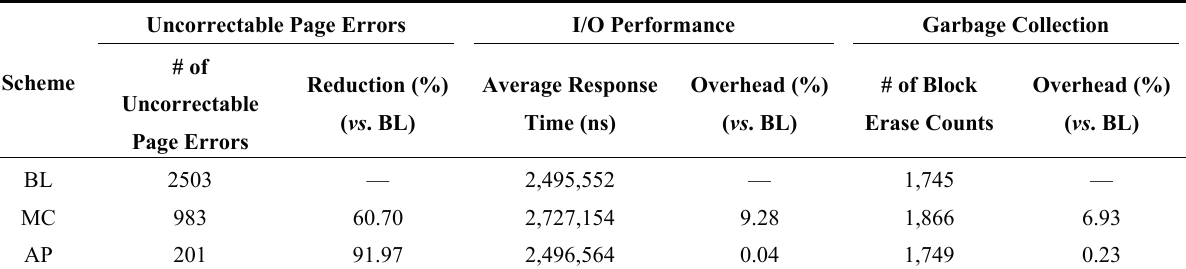
Table 4. The experimental results of Baseline, Meta-Cure, and Asymmetric Programming with Zynq on-board sensor system (BL: Base Line; MC: Meta-Cure; AP: Asymmetric